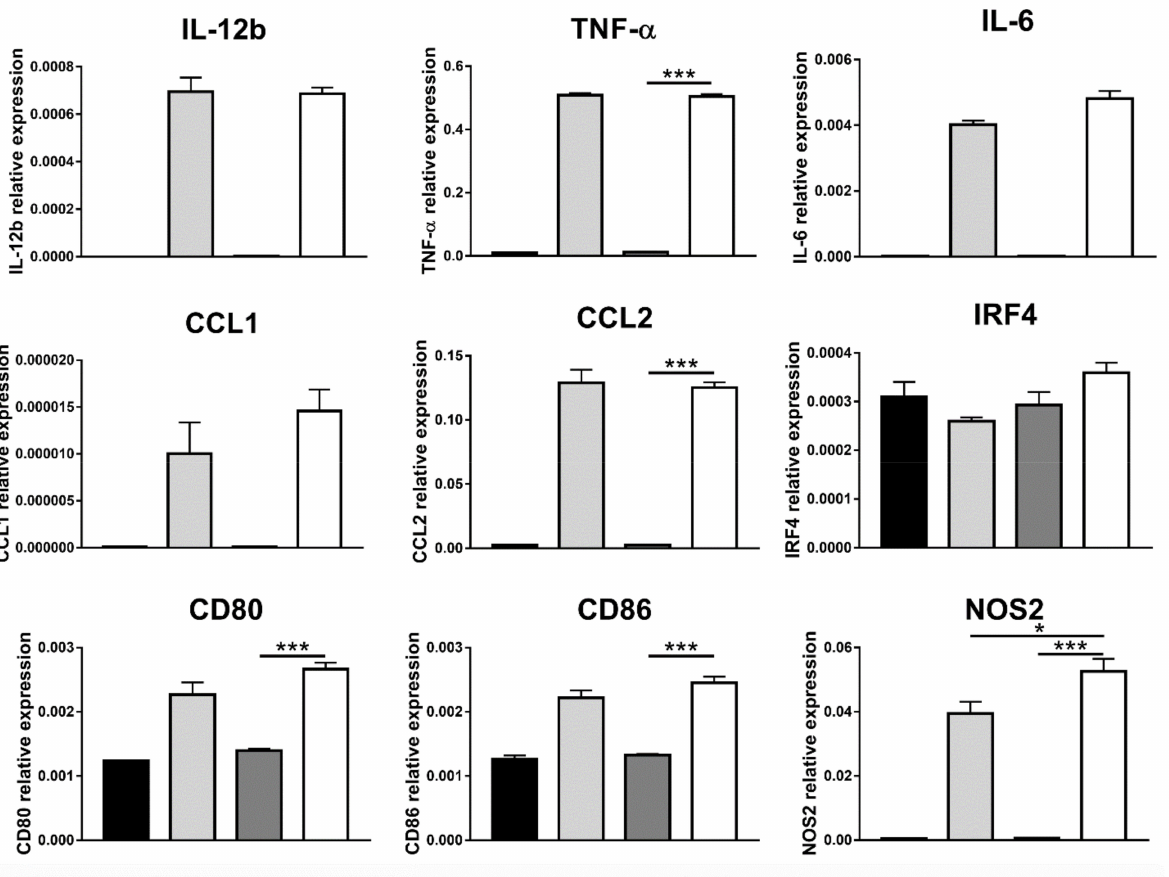
Figure 6. Effect of the combination of CpG-ODNs and the Fc silent anti-mouse PD-1 antibody on RAW264.7 macrophages in vitro. RAW264.7 macrophages were seeded in 12-well plates and then stimulated with 1 µ M CpG-ODN and 10 µ g/mL Fc silent anti-mouse PD-1 antibody alone or in combination for 6 h. Controls were left untreated. At the end of treatment, mRNA was extracted, and real-time PCR was performed. The data were normalized to the expression of β 2m as a housekeeping reference gene and analyzed by the comparative 2 − ∆ Ct method. The data are presented as the mean ± SEM and were analyzed by one-way ANOVA followed by Tukey’s multiple comparison test with a single pooled variance or by the Kruskal–Wallis test followed by Dunn’s multiple comparison test for nonparametric data. * p < 0.05 and *** p < 0.001. CpG-ODNs: CpG oligodeoxynucleotides; anti-PD-1 Ab: anti-PD-1